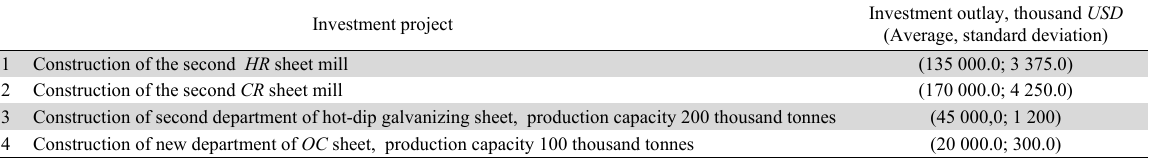
Investment project